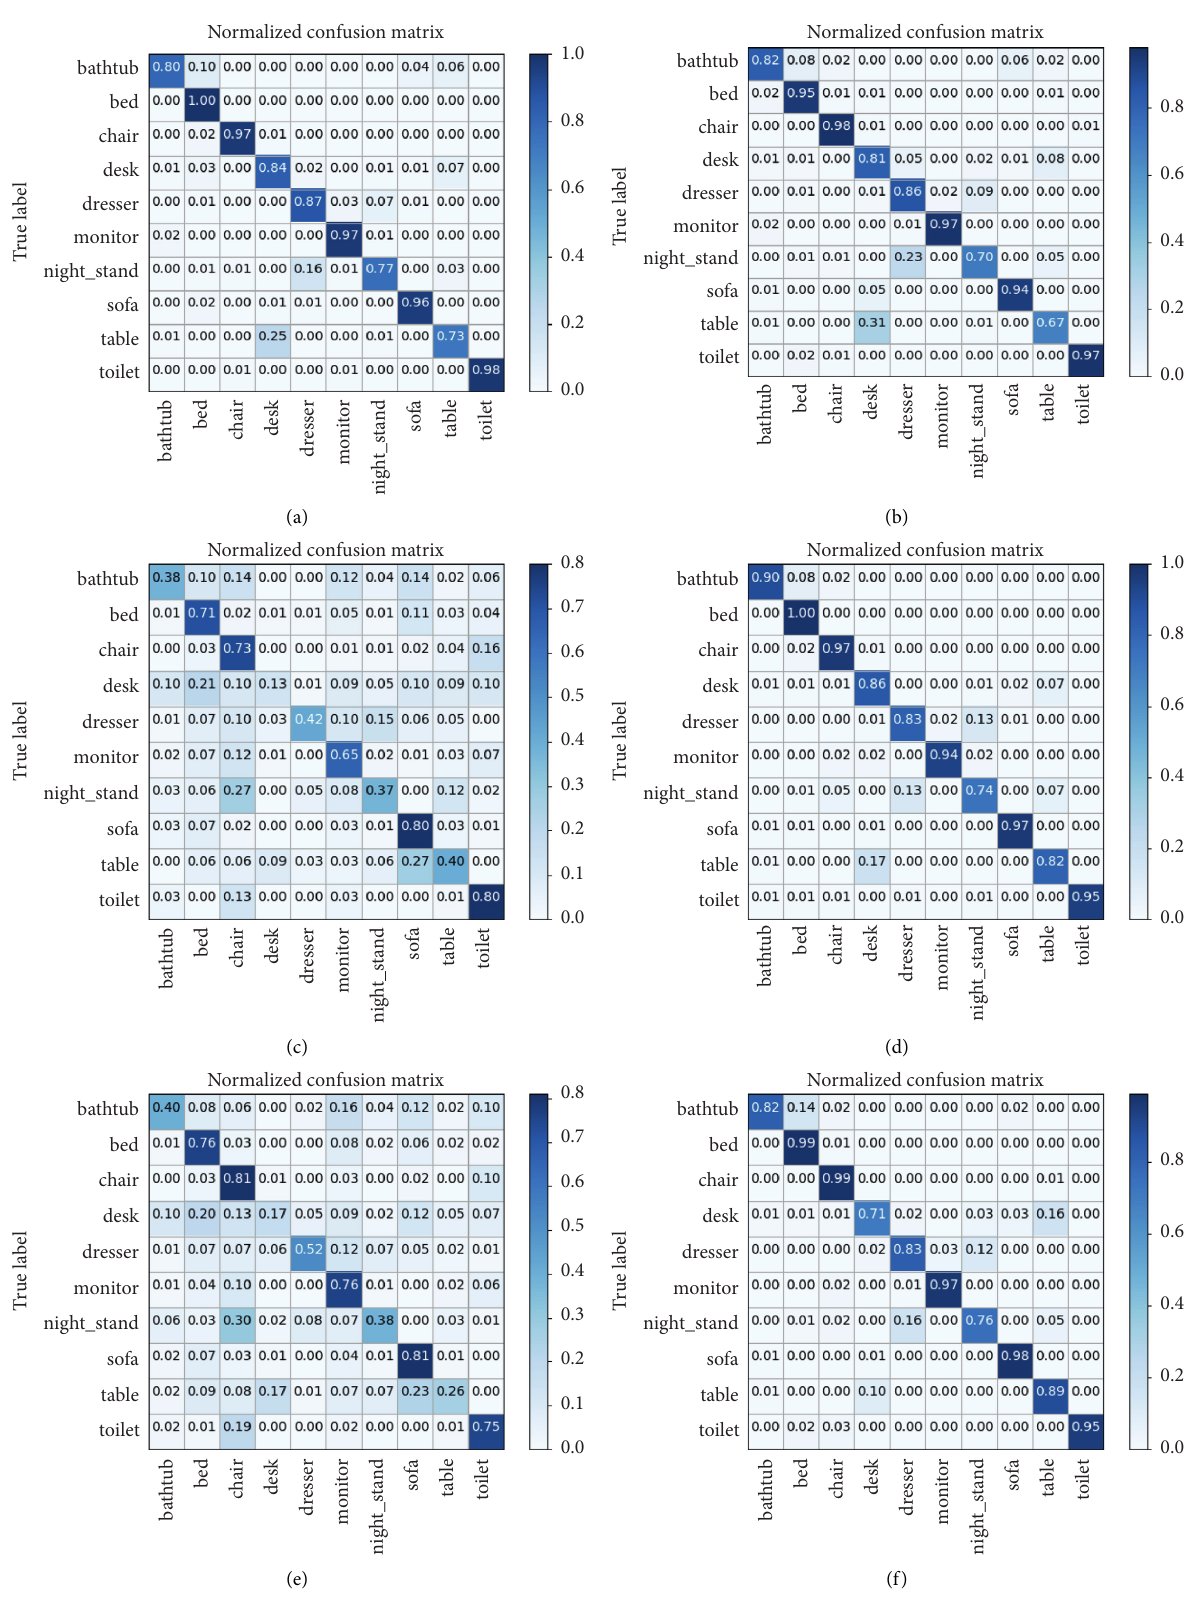
Figure 6: Confusion matrix: (a) softmax classifier based on voxel+ D 1+D2 + D 3+A3 feature; (b) softmax classifier based on voxel feature; (c) softmax classifier based on D 1+ D2+ D 3+ A3 feature; (d) strong Bayesian classifier based on voxel+ D 1+D2+ D 3 +A3 feature; (e) strong Bayesian classifier based on D 1+ D2+ D 3+A3 feature; (f) strong Bayesian classifier based on voxel